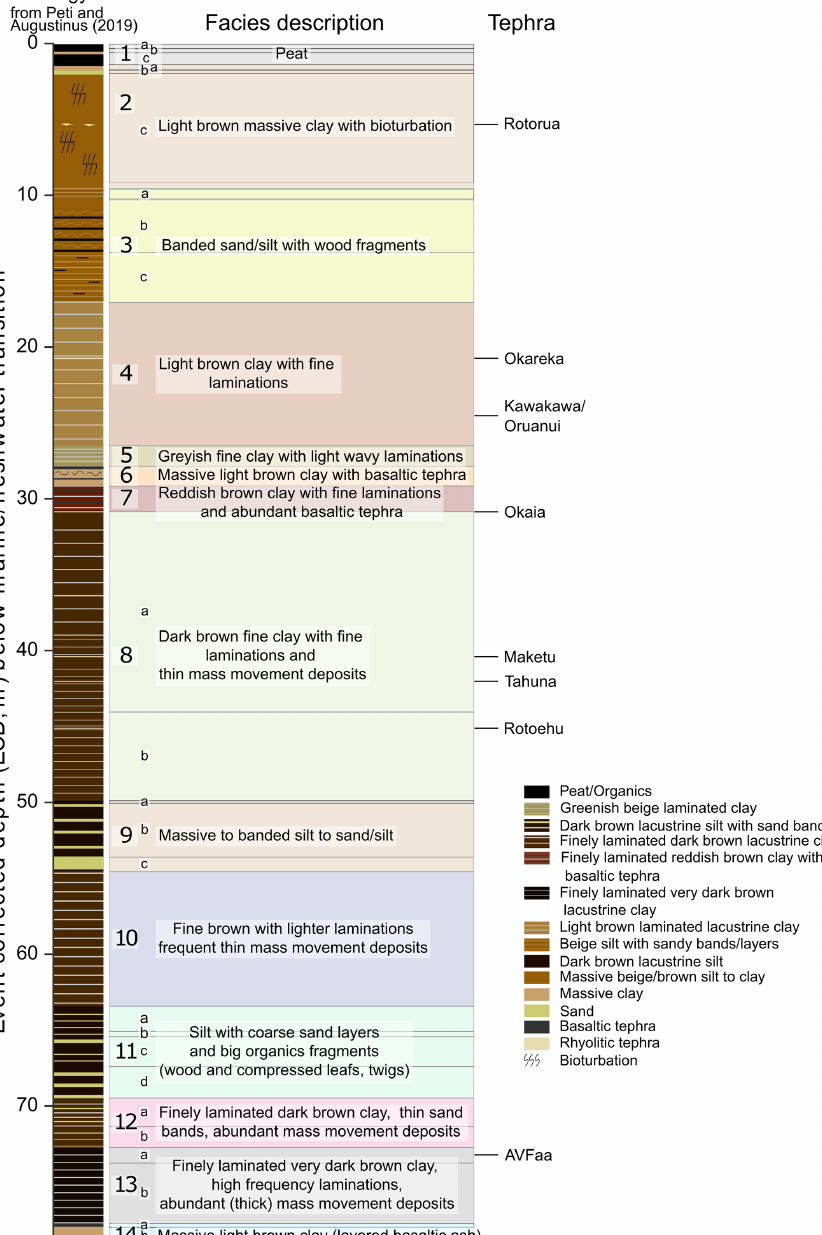
trations were determined using the ZAF 1 correction